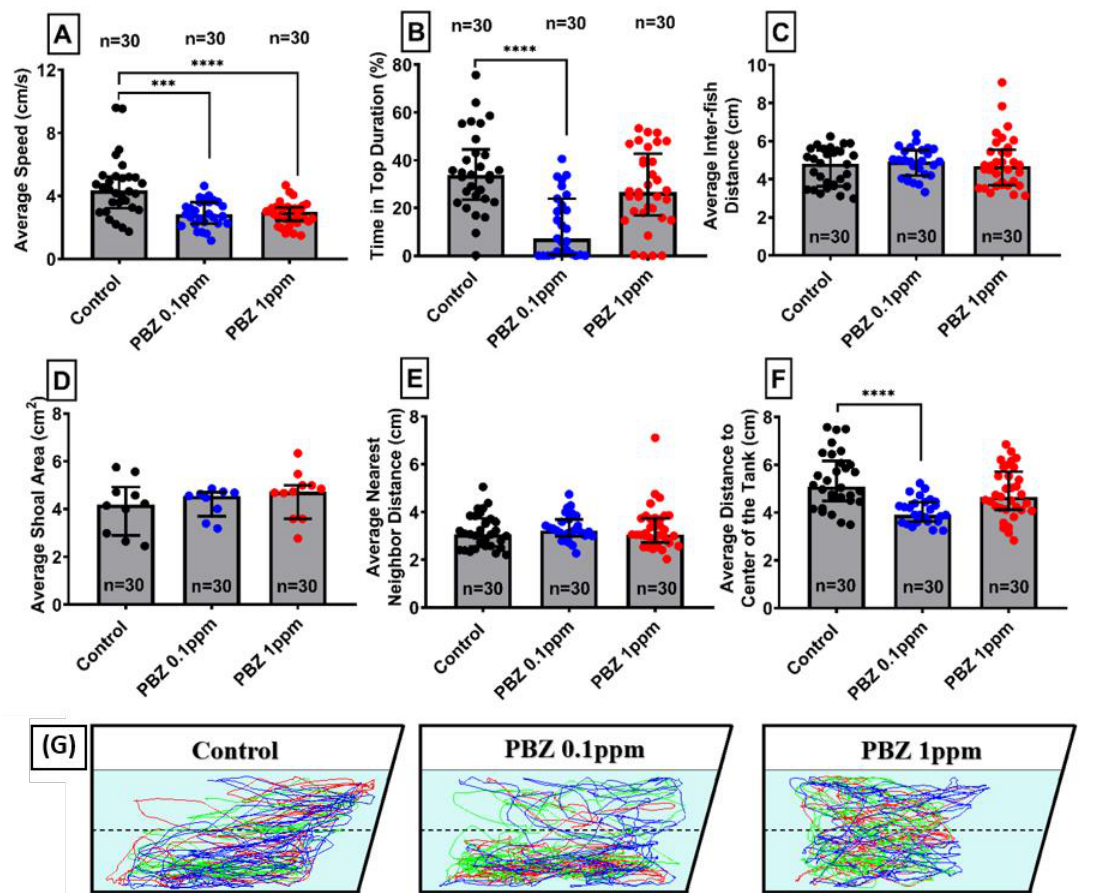
Figure 9. Shoaling test for adult zebrafish after exposed to di ff erent doses of Paclobutrazol. Six behavioral endpoints were tested including: ( A ) average speed, ( B ) time in top, ( C ) distance between individual fish, ( D ) average shoal area, ( E ) average nearest neighbor distance, and ( F ) average farthest neighbor distance. ( G ) Trajectories of adult zebrafish in shoaling assay after exposed to 0 (control), 100 µ g / L (0.1 ppm), and 1000 µ g / L (1 ppm) of Paclobutrazol (PBZ). The shoal size for every group was three fish. The data are expressed as the means ± S.E.M. and were analyzed by the one-way ANOVA (*** p < 0.001, **** p < 0.0001).